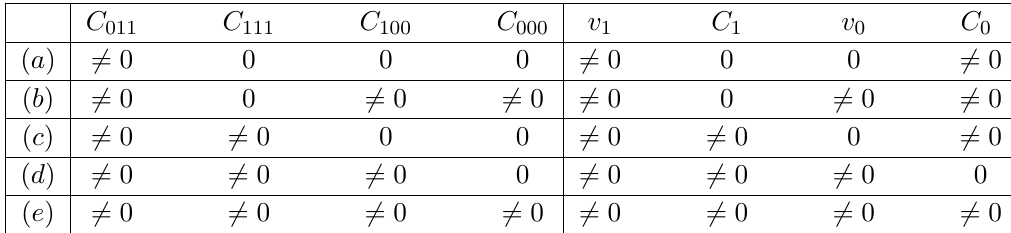
Table 1 . The five different supergravity theories (defined by the C IJK on the left part) coupled to one vector multiplet whose U(1) gauging reproduces the potential of LST, and the associated R constants (on the right